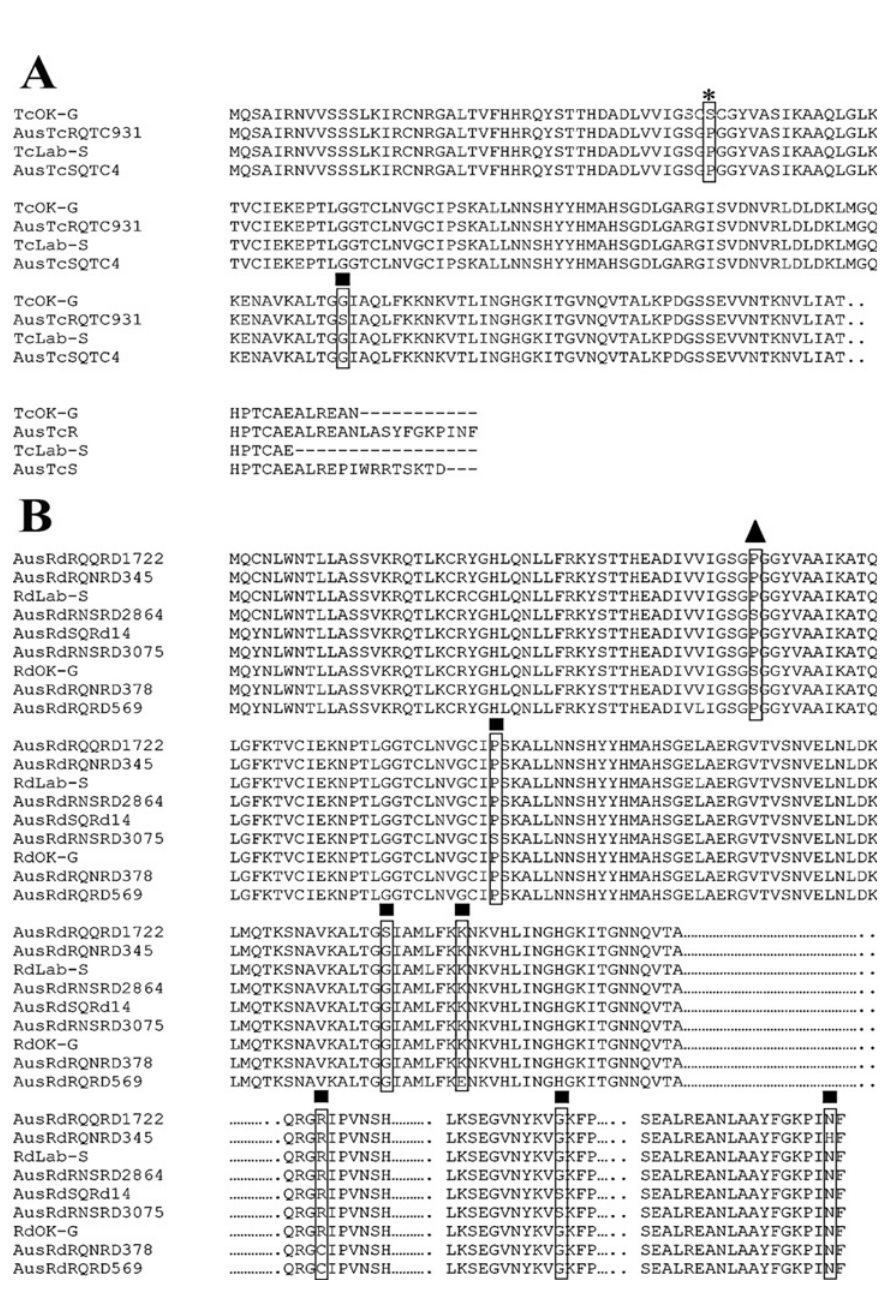
Fig 2. Deduced amino acid sequences of DLD from T . castaneum and R . dominica by ClustalW2. Only the portions of the amino acid sequences with relevant mutations in both species are shown. Fig 2A: Sequences from susceptible and resistant strains of T . castaneum from the USA aligned against Australian strains. Fig 2B: Sequences from susceptible and resistant strains of R . dominica from the USA aligned against Australian strains. Differences between the phosphine-susceptible and phosphine-resistant sequences are boxed. The asterisk denotes the P45S phosphine-resistance mutations described in the T . castaneum population TcOK-G. The triangle denotes the P49S phosphine-resistance mutations described in the text. The squares denote all the other phosphine-resistance mutations described only in Australian